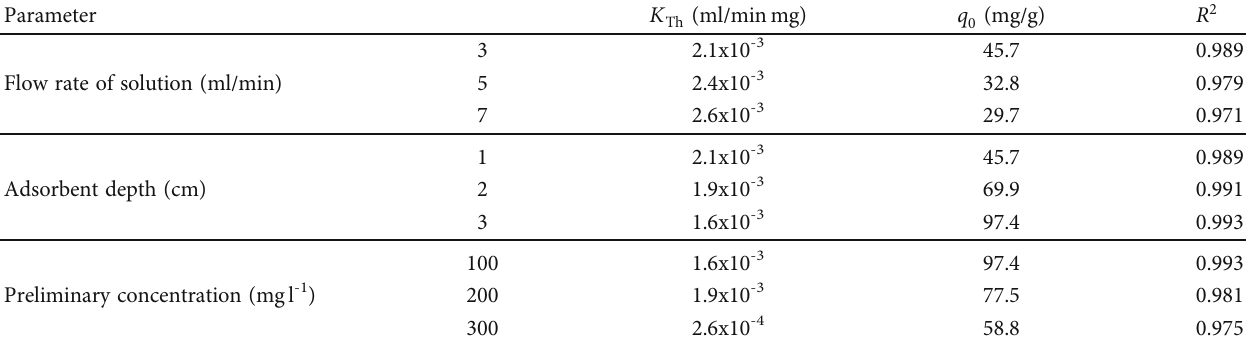
Table 3: Parameters and constants of the Thomas model for the removal of CV by